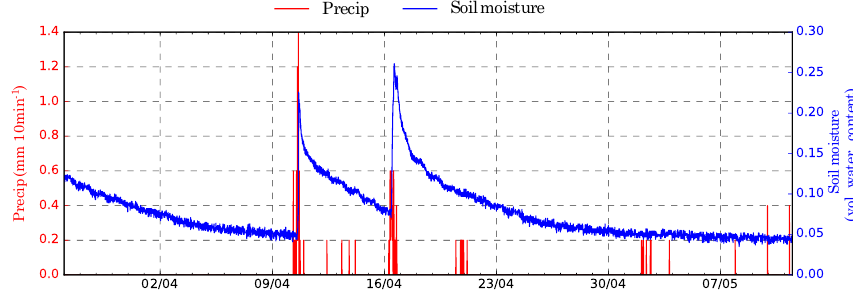
Figure 4. Precipitation and 0–10cm soil moisture for the month leading up to and including the field campaign.